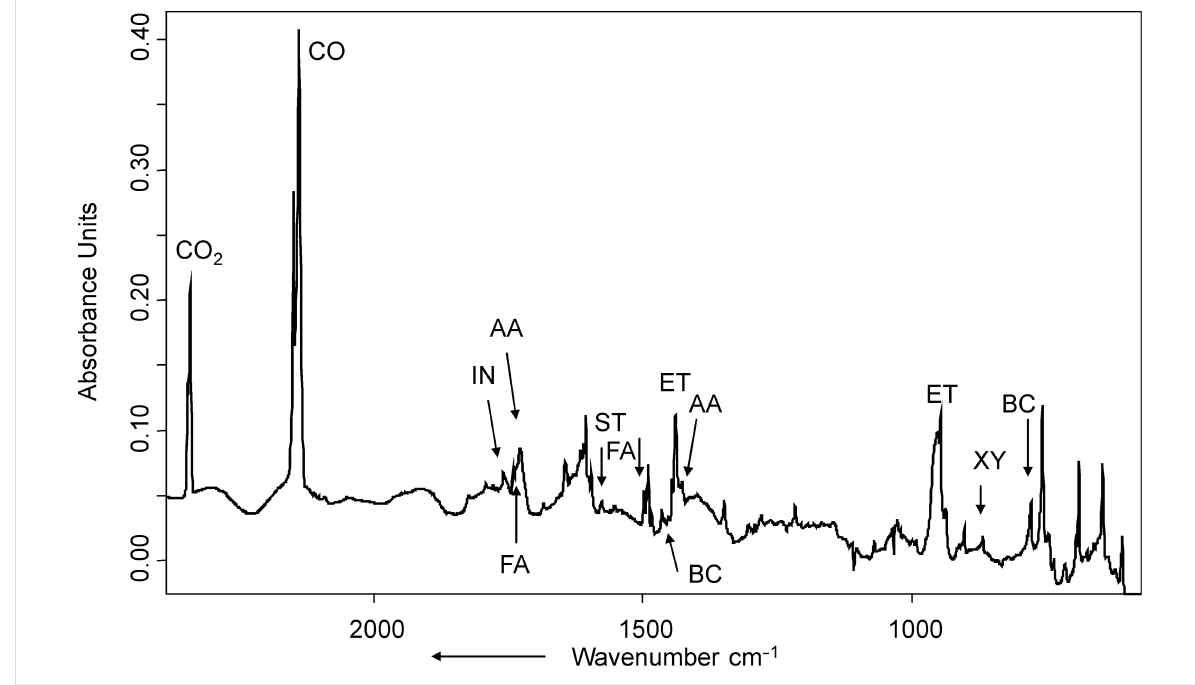
Figure 4: Infrared spectrum obtained upon FVP of 1 at T = 1143 K and trapping the pyrolysate in solid argon at T = 10